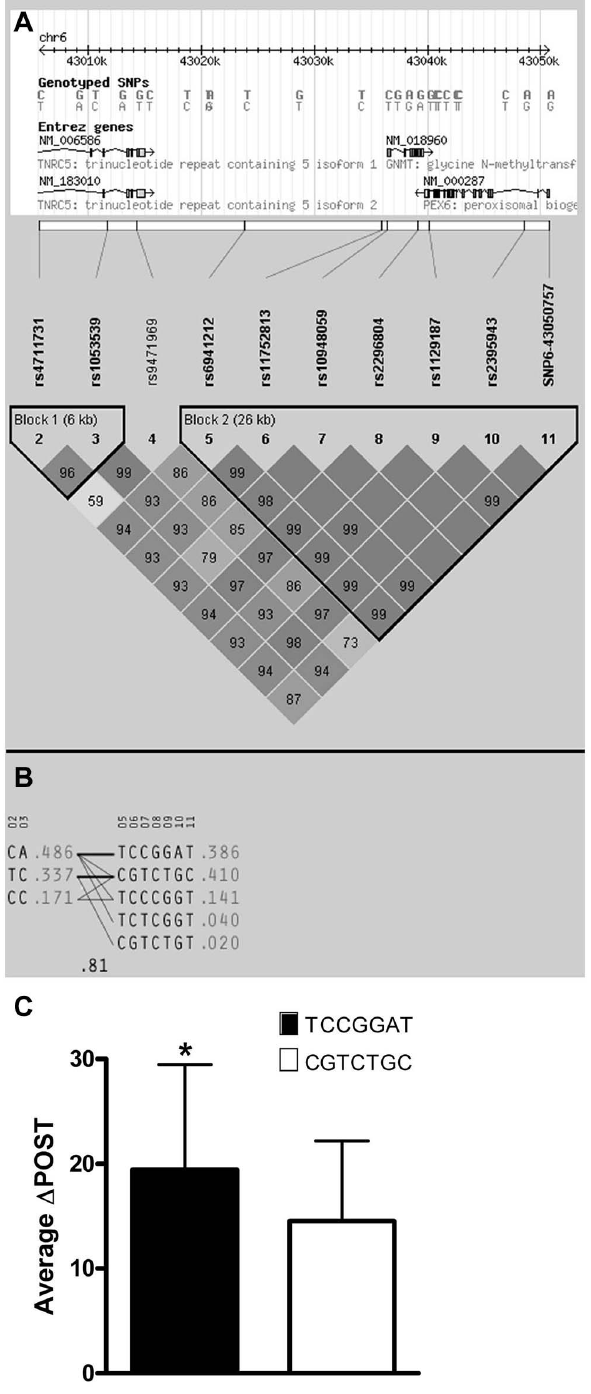
Figure 2. Haplotype analysis of Chr6 SNPs significantly- associated with D POST in the VISP cohort. Haplotype analyses of the 10 most-associated SNPs, which are all genome wide significant, from chromosome 6, were performed using Haploview version 4.2 [13]. (A) Shows results for the chromosome 6 genomic haplotype structure in VISP, encompassing the GNMT gene. Genetic coordinates, Entrez gene structure, haplotype blocks and linkage disequilibrium (LD) pattern between SNPs are shown. Within LD pattern, r 2 values are shown and are represented by shading. The darker the shading the closer the r 2 value is to 1.0. All SNPs assessed were genotyped. (B) Shows haplotypes generated by Haploview for haplotype blocks 1 and 2. Haplotype